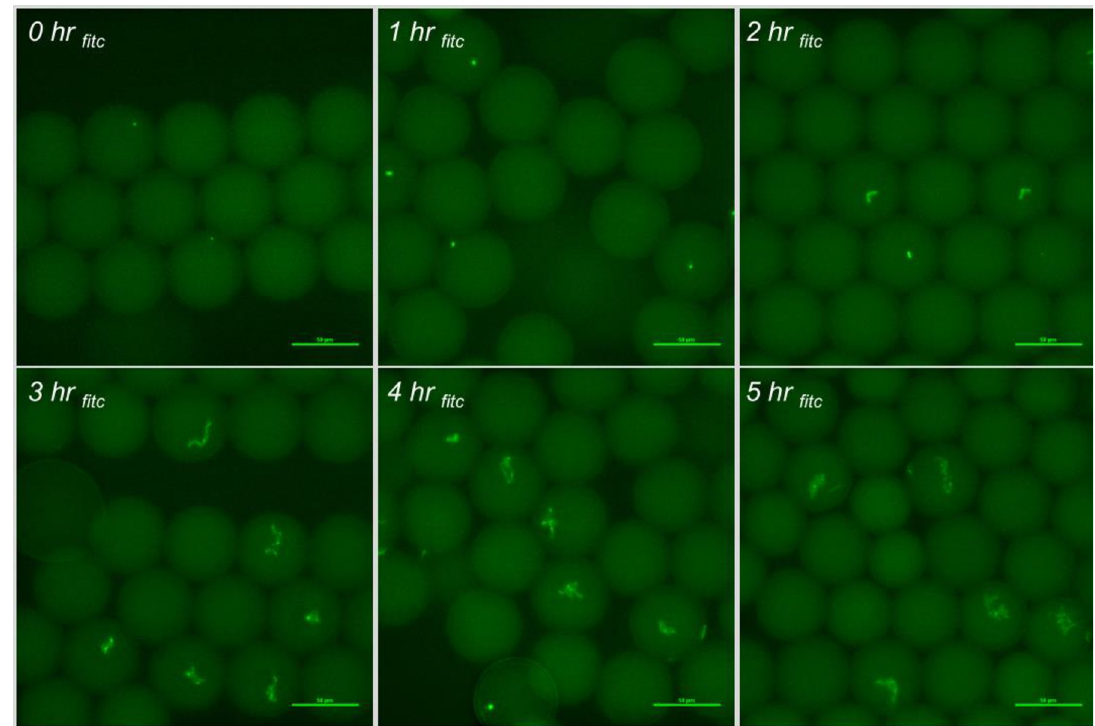
Fig 8. Fluorescent images of S . Typhimurium incubation in-droplet with 0.5x shredded lettuce wash water, and 10 μ g/ml FITC-Ab in 1x RV broth at 37˚C.